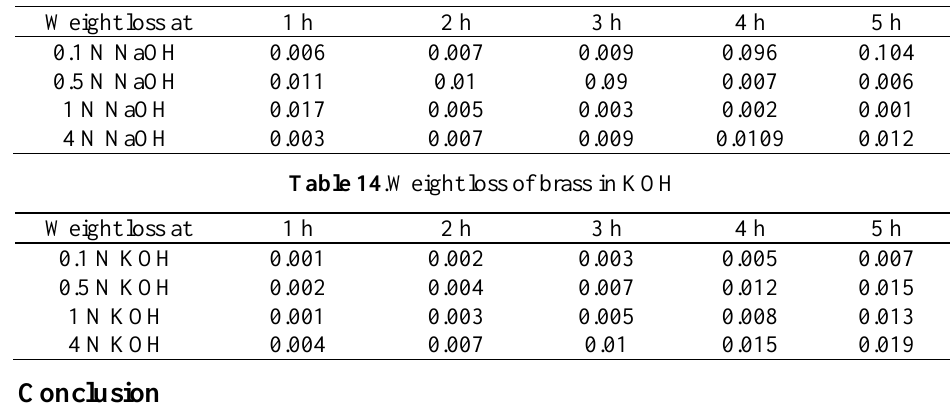
Table 13. Weight loss of Brass in NaOH